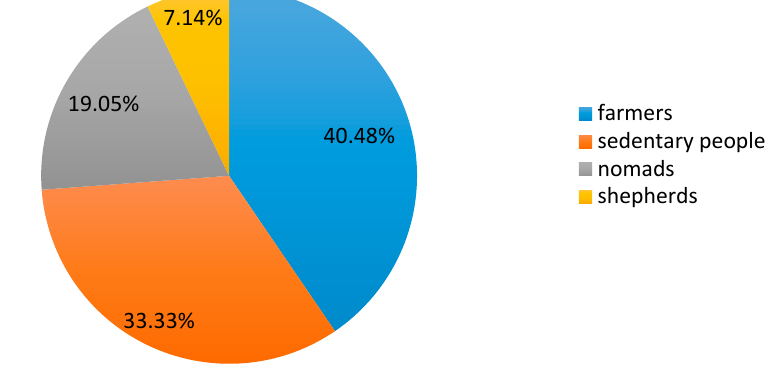
Figure 2. Type of Salvia argentea collectors.